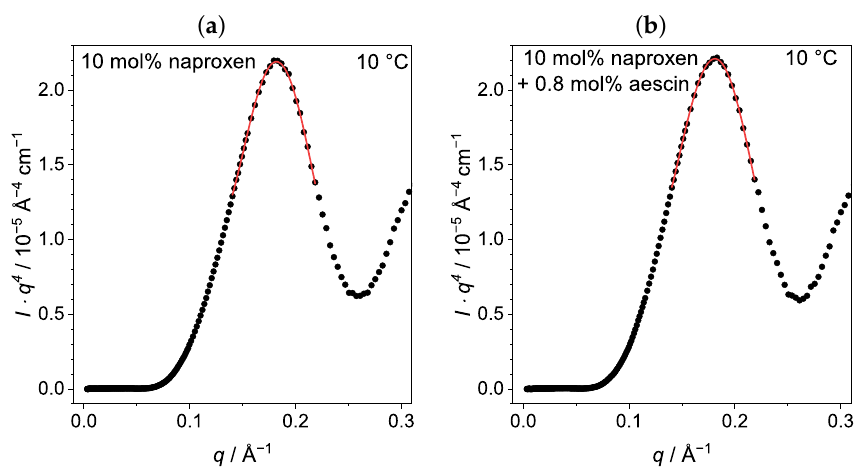
Figure 7. MKP plots for DMPC vesicles ( a ) with 10mol% naproxen and ( b ) with 10mol% naproxen and 0.8mol% aescin at T = 10 °C. Red lines are fourth-order polynomial fits.